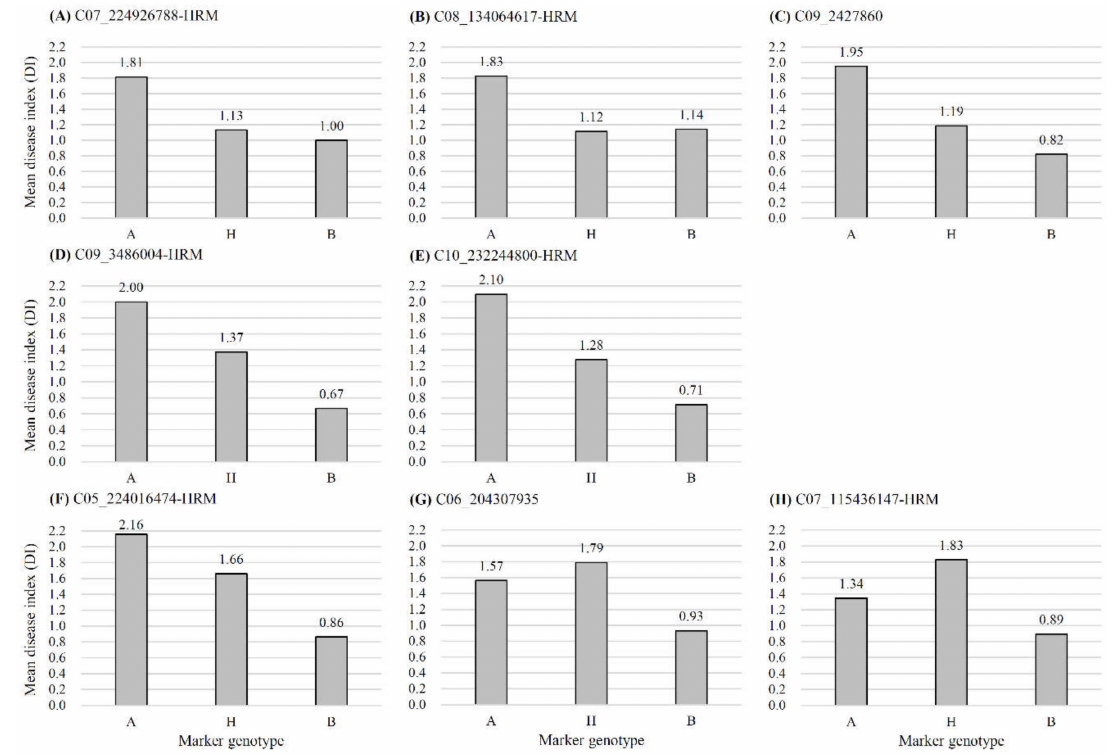
Figure 4. Comparison of mean disease index (DI) for bacterial wilt caused by ‘HS’ ( A – E ) and ‘HWA’ ( F – H ) isolates of Ralstonia solanacearum between genotypes of the HRM or SNP markers closely linked to one of the eight QTLs detected in this study. A, maternal genotype; B, paternal genotype; H, heterozygous genotype. ( A ) H and B genotypes of a marker, C07_224926788-HRM, linked to the QTL Bwr6w-7.2 showed more resistance than A genotype. ( B ) H and B genotypes of a marker, C08_134064617-HRM, linked to the QTL Bwr6w-8.1 showed more resistance than A genotype. ( C ) An SNP, C09_2427860, linked to Bwr6w-9.1 showed an additive effect on mean disease index depending on genotypes. ( D ) A marker, C09_3486004-HRM, linked to Bwr6w-9.2 showed an additive effect on mean disease index depending on genotypes. ( E ) A marker, C10_232244800-HRM, linked to Bwr6w-10.1 showed an additive effect on mean disease index depending on genotypes. ( F ) A marker, C05_224016474-HRM, linked to Bwr6w-5.1 showed an additive effect on mean disease index depending on genotypes. ( G ) B genotype of SNP C06_204307935 linked to the QTL